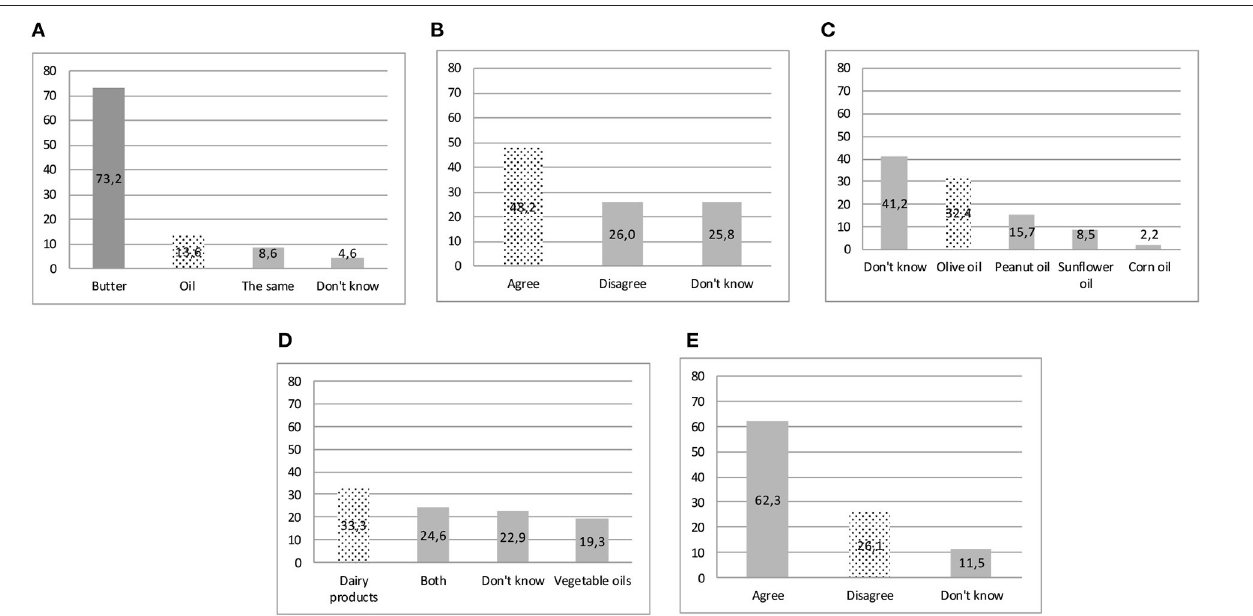
FIGURE 2 | Nutrient composition of food—correct answers in the dotted bar. (A) Highest calorie-food. (B) Some foods contain a lot of fat but no cholesterol. (C) Oil containing mostly monounsaturated fat. (D) Saturated fat could be found mainly. (E) Brown sugar is a healthy alternative to white